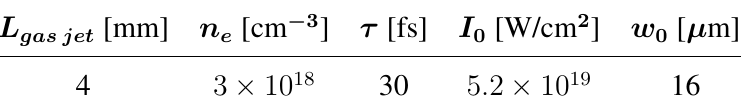
Table 2. A possible working point of the self-injection test experiment at FLAME for laser-acceleration in the GeV scale.